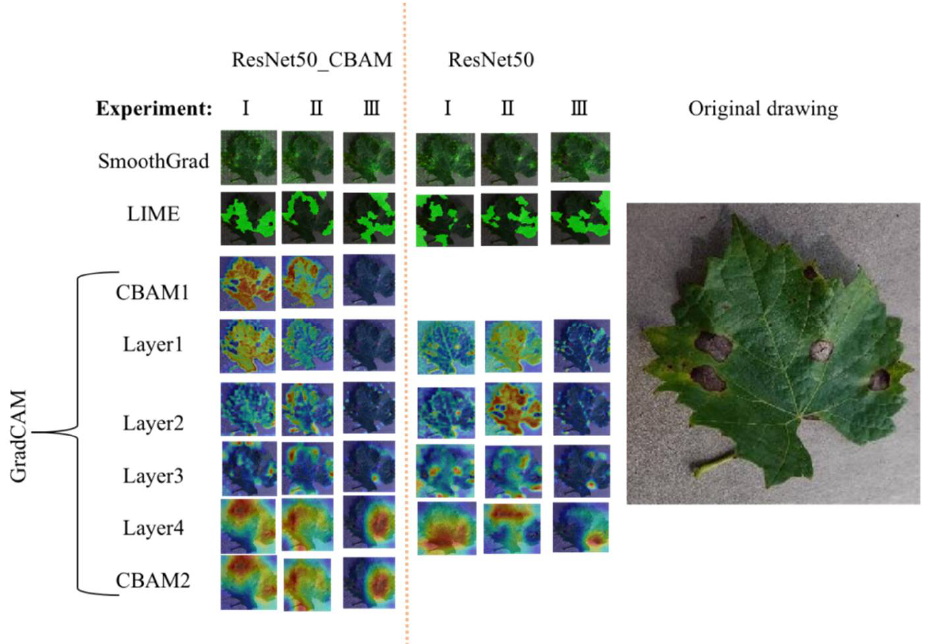
Figure 8. Comparison of the same disease picture in model ResNet50-CBAM and ResNet50. The rows represent the display results of the three interpretable methods. The left side of the dotted line in the figure shows the results of the ResNet50-CBAM model on three sets of experiments, and the right side shows the results of the ResNet50 model on the three sets of experiments.